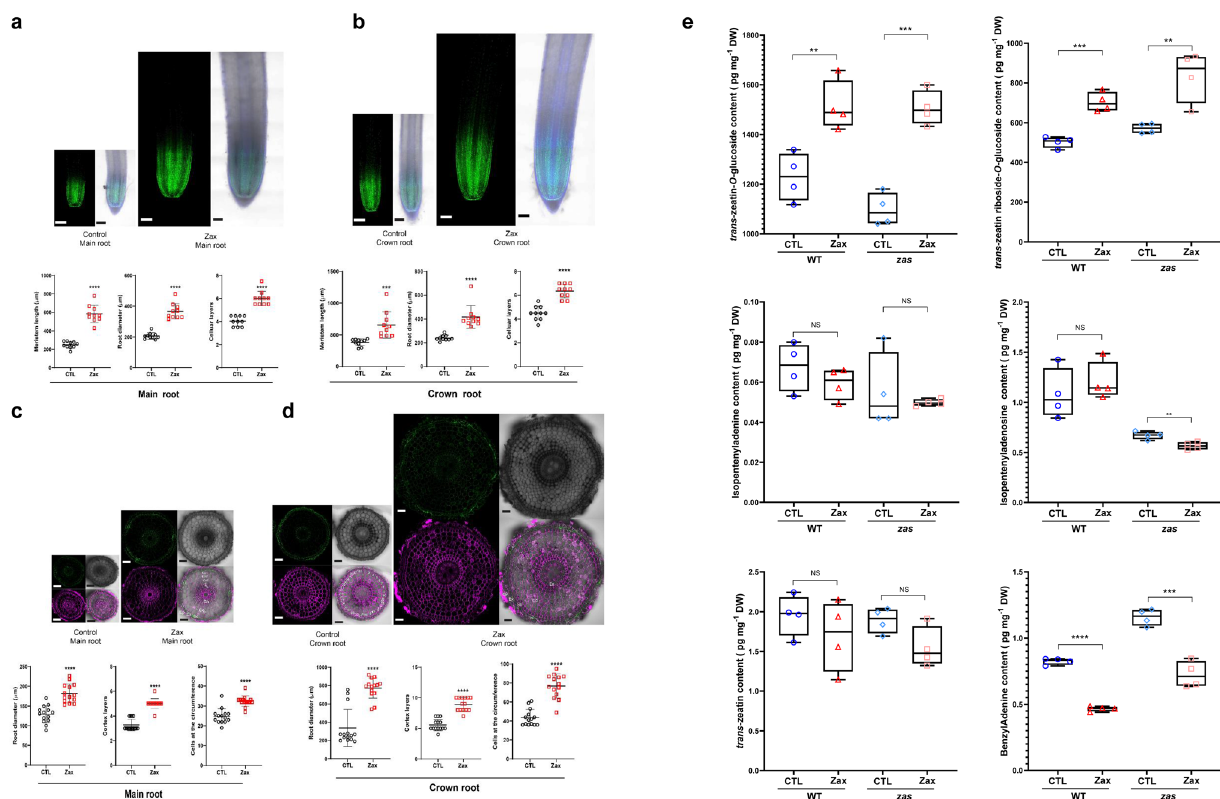
Fig. 4 Characterization of root development at cellular level upon zaxinone treatment. a , b Ethynyl deoxyuridine (EdU) staining for cell proliferation analysis. Confocal images of rice root showing dividing cells as captured by EdU staining in Zeiss LSM 710 inverted confocal microscope. Root meristem length, root diameter, and cell layers (counted from epidermis to vascular tissue) in both primary roots and crown roots after 5 µ M zaxinone treatment (twice per week) in Nipponbare WT rice seedlings. Dividing EdU-stained nuclei are shown in green; nuclei counterstained with Hoechst 33258 are shown in magenta. Images were acquired using the tile scan function in the Zen software with automatized stitching. Regions of interest were divided into multiple tiles and imaged individually. The tiles were then combined via automatic stitching to create a large overview image. Images are representative of the total number ( n = 10) of seedlings that were studied. Scale bar: 50 µ m. c , d Cross section of the mock and zaxinone-treated roots stained with SCRI Renaissance 2200. Magenta indicates the cell wall staining; green shows the auto- fl uorescence marking lignin and suberin deposition ( n = 14 biological replicates). Examples of cell layer and circumference cell number count are indicated in the cross section d, scale bar: 50 µ m. e Quanti fi cation of cytokinins in root tissues of WT and zas mutant after 2-week zaxinone treatment. Box plot presented as min to max, n = 4 biological replicates. Asterisks indicate statistically signi fi cant differences as compared to control by t -test (* p < 0.05, ** p < 0.01; *** p < 0.001; **** p < 0.0001). CTL control, Zax zaxinone. Ep epidermis,